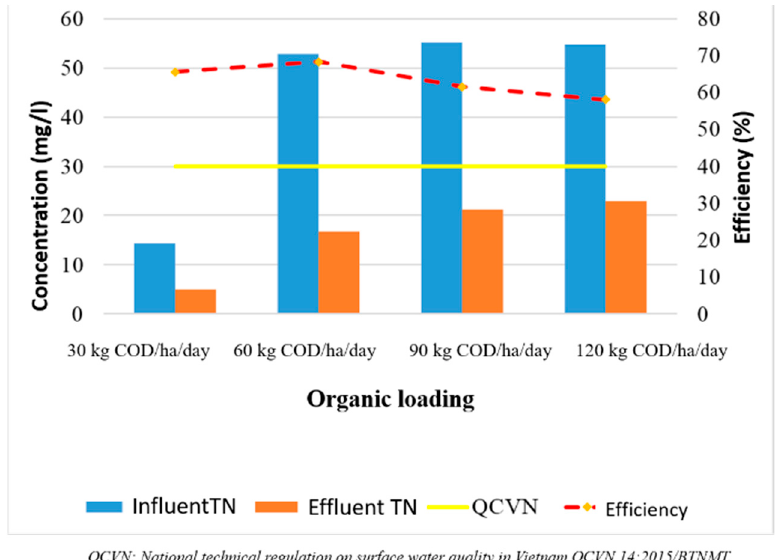
Figure 2. Effect of organic loading on Nitrogen Total removal efficiency.